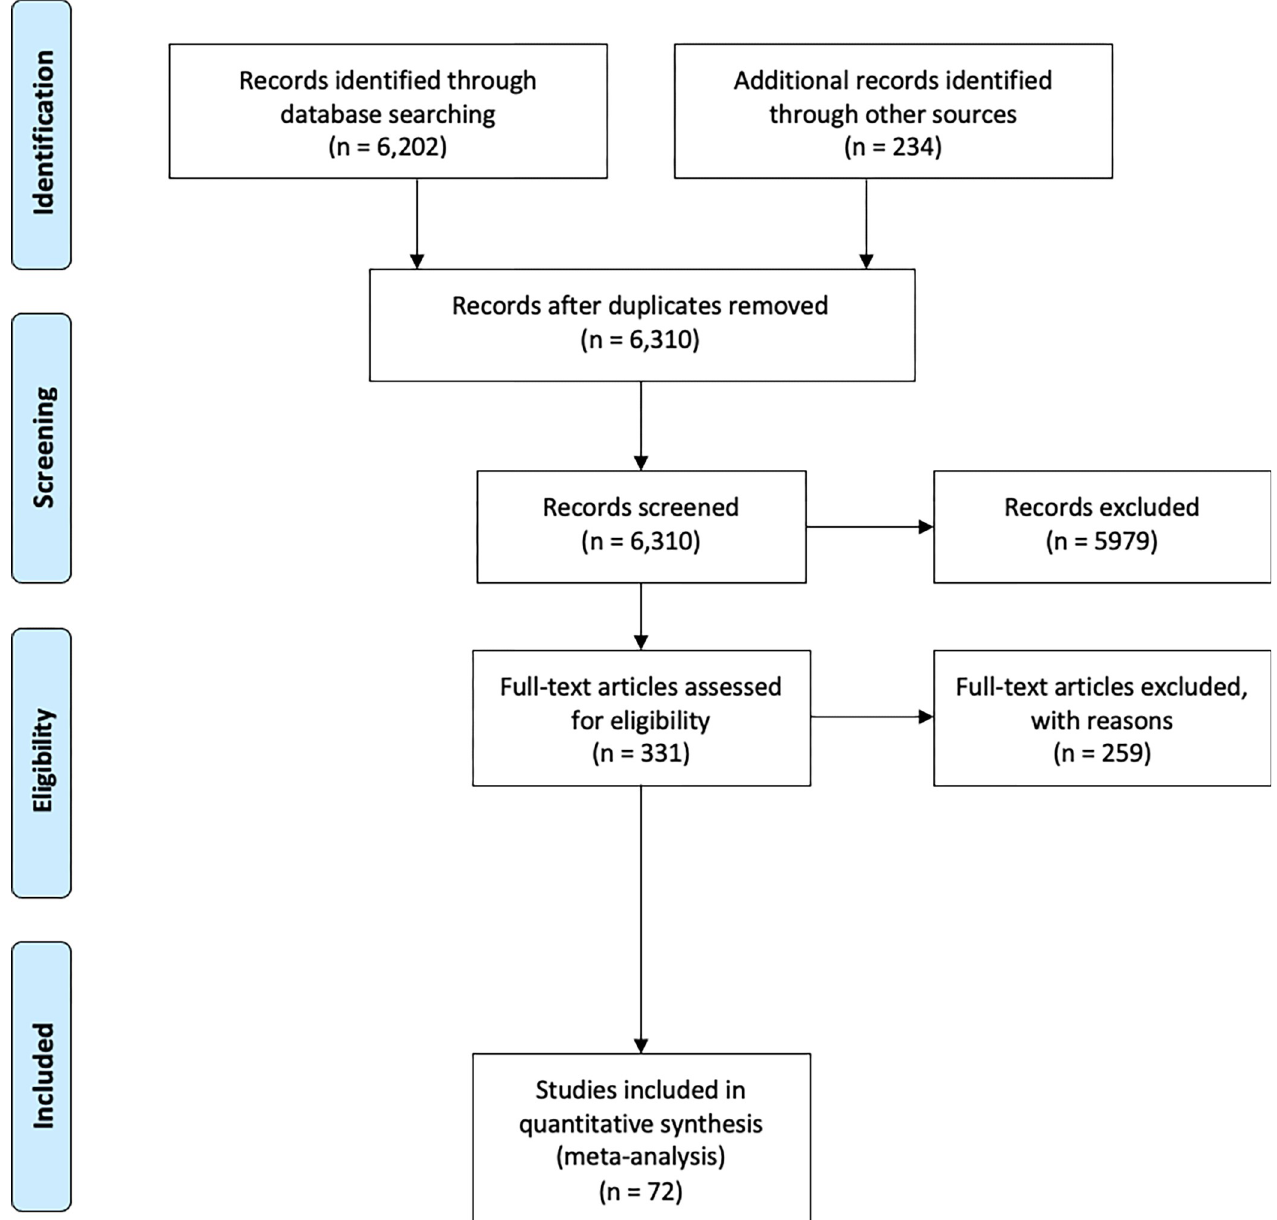
Fig 1. Overview of systematic review